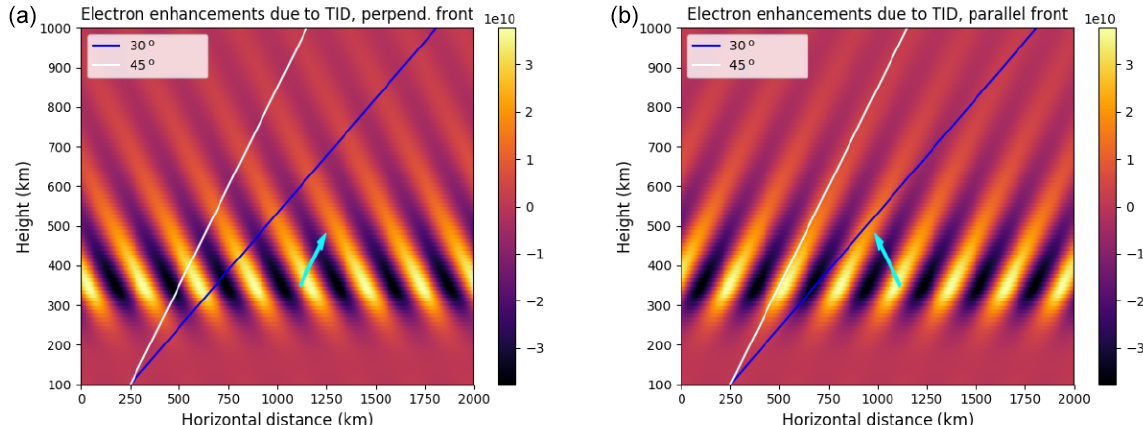
Figure 5. Model of electron enhancements due to TIDs. (a) The TID-phase front has been tilted 45 ◦ to the left. Radar look directions for 45 and 30 ◦ above the horizon are shown. (b) The same as the plot on the left but with the TID-phase front tilted 45 ◦ to the right. Both are in units of electrons per cubic meter. The TID wave vector is displayed as a cyan arrow.